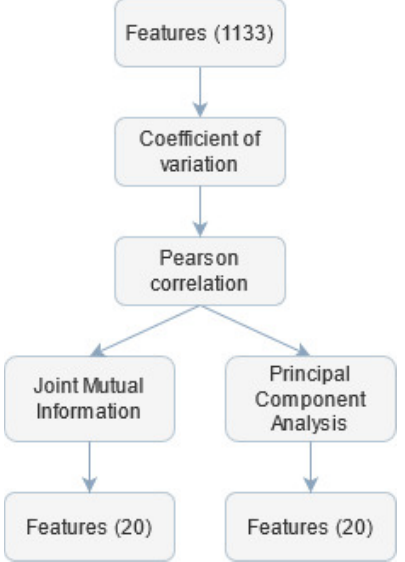
Figure 4. Subsequent steps of feature